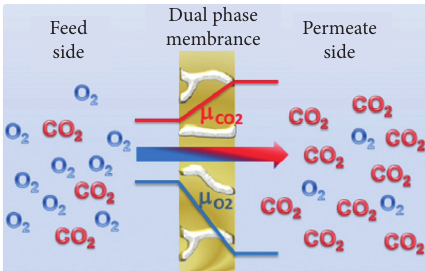
Figure 1: Membrane separation mechanism based on partial pressure difference across the membrane. Pressure difference (driving force), membrane thickness, and surface area are key parameters for membrane performance